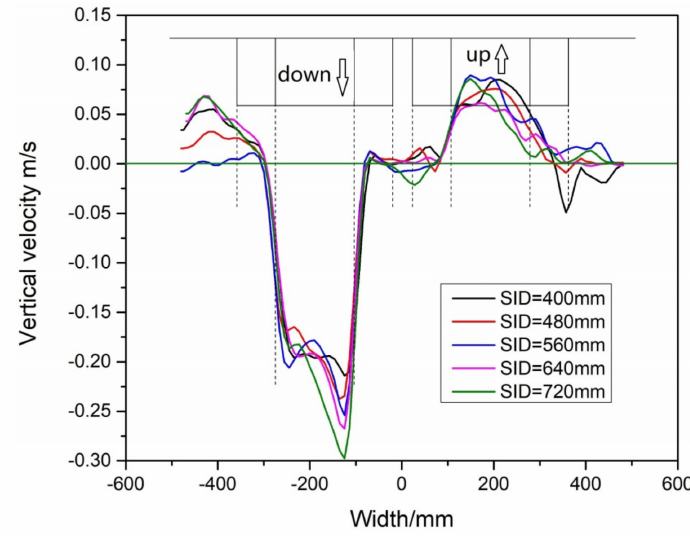
Figure 9. Vertical velocity distribution of flow field in transition layer with di ff erent SIDs.